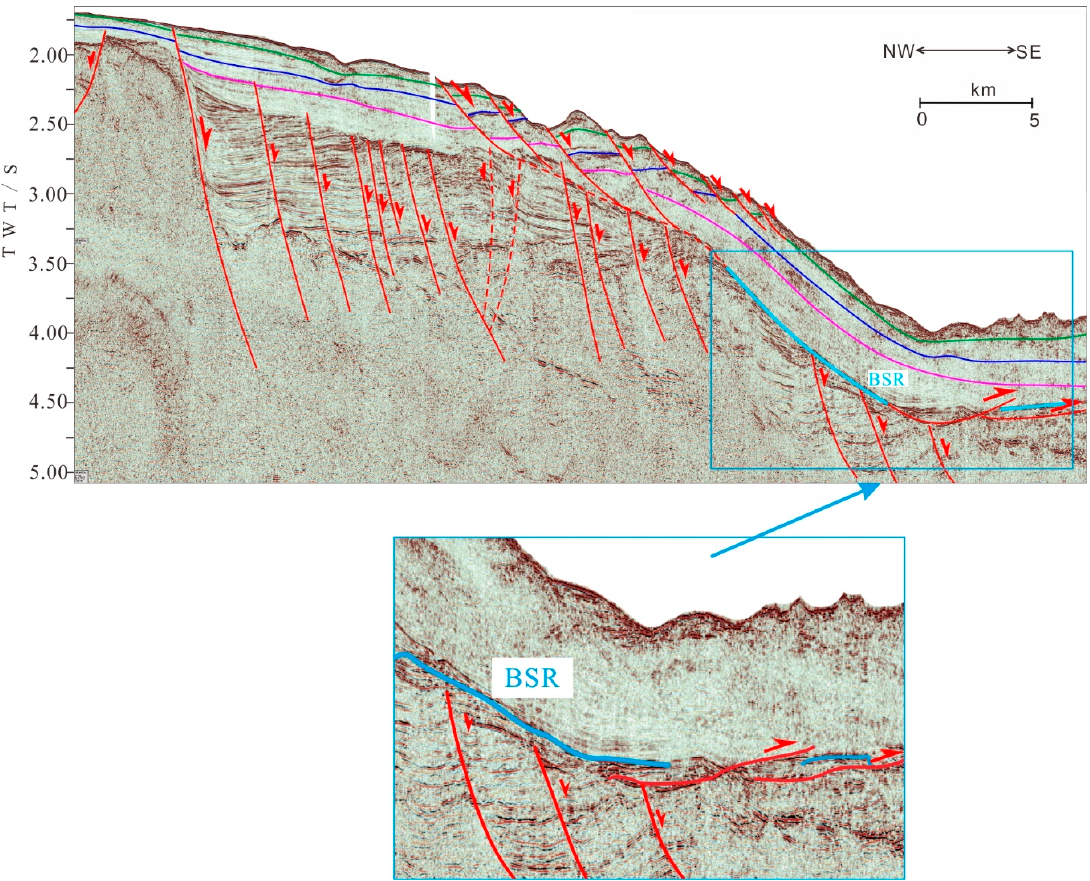
Figure 11. Seismic reflection of Line 10 is post-gas hydrate landslide.